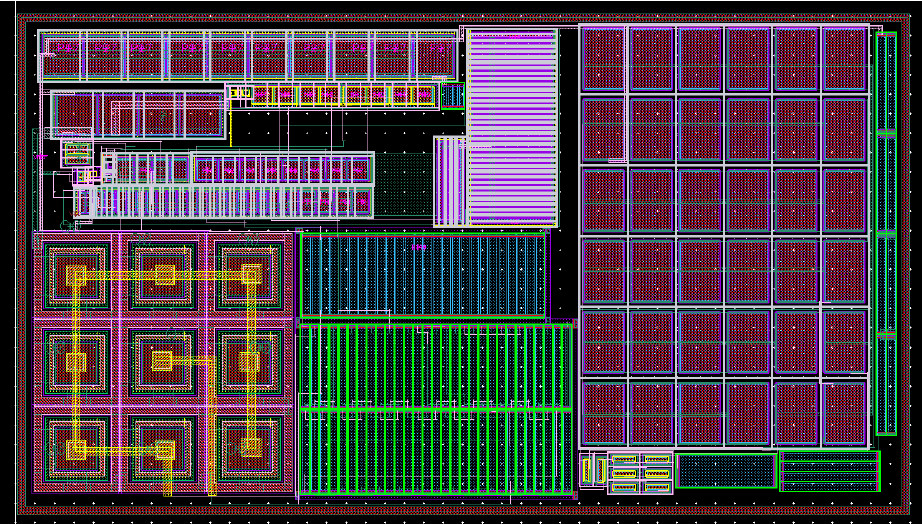
Figure 14. The layout of the proposed BGR circuit.